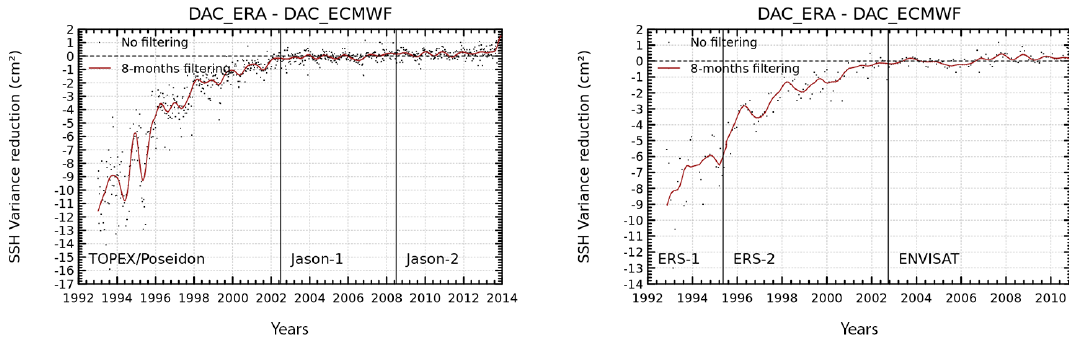
Figure 7. Temporal evolution of SSH variance differences at crossovers successively using the ERA-Interim and reference DAC solutions in the SSH calculation for TOPEX/Jason-1/Jason-2 time series (on the left), and ERS-1/ERS-2/Envisat time series (on the